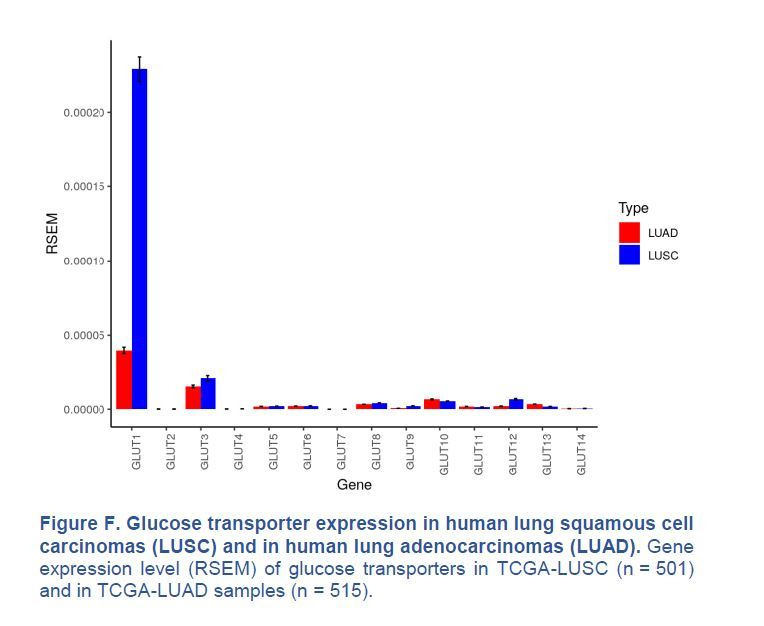
Glucose transporter expression in human lung squamous cell carcinomas (LUSC) and in human lung adenocarcinomas (LUAD).Gene expression level (RSEM) of glucose transporters in TCGA-LUSC (n = 501) and in TCGA-LUAD samples (n = 515).